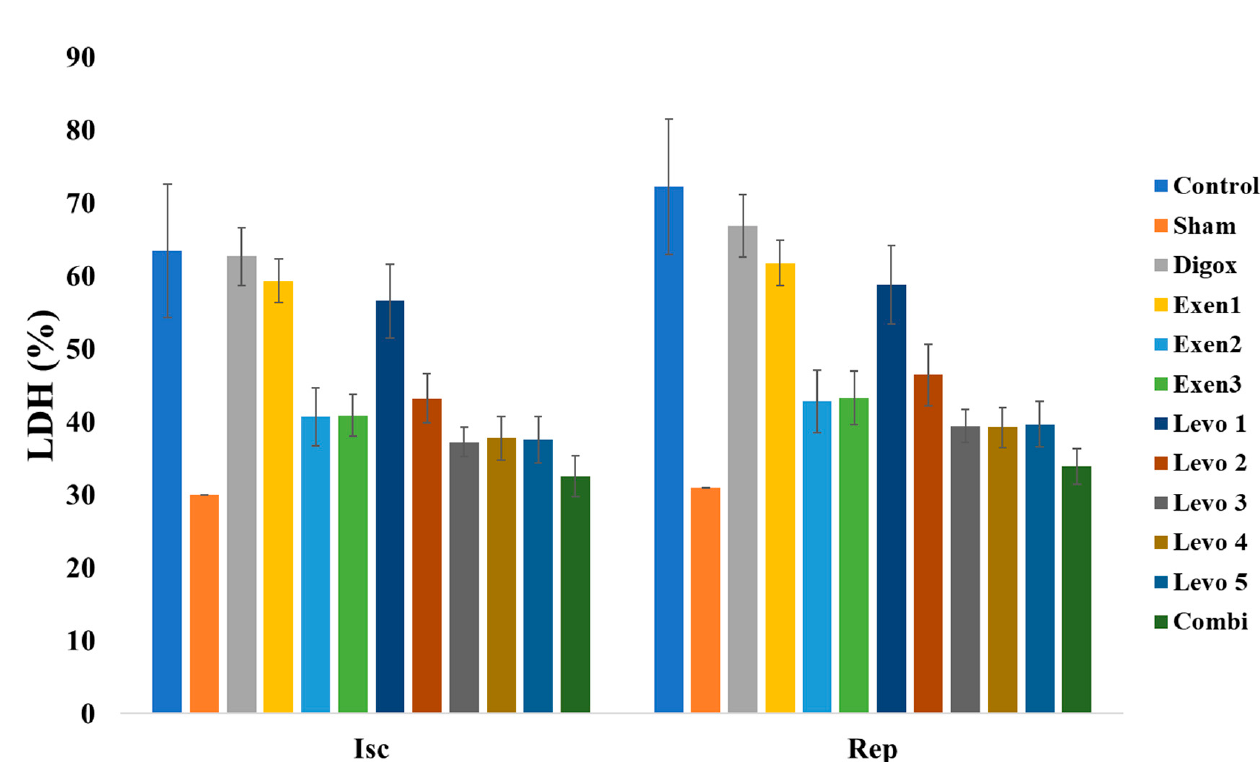
Figure 14. Changes in LDH across groups over time.